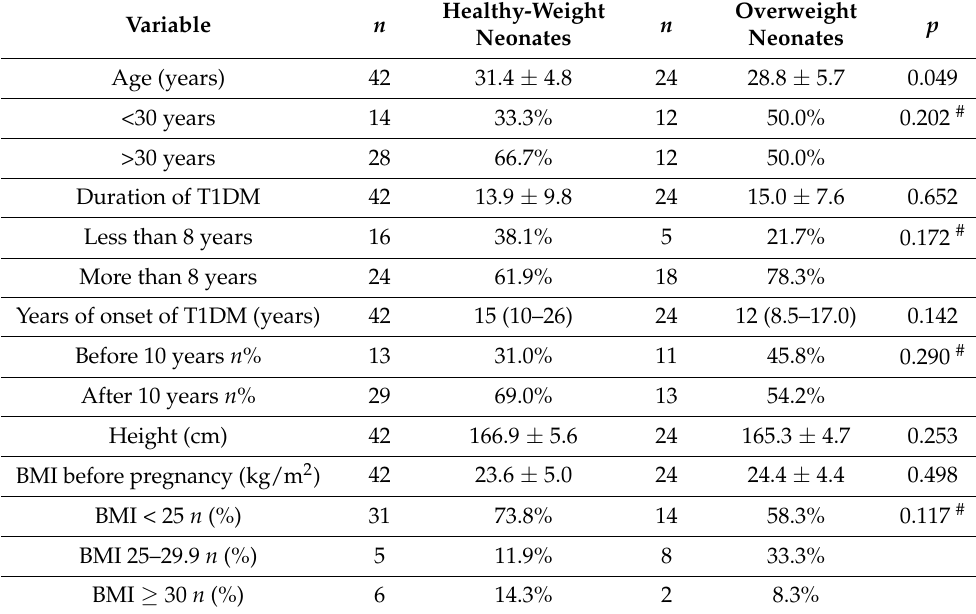
Table 3. Maternal demographics, obstetric, and laboratory data of two study